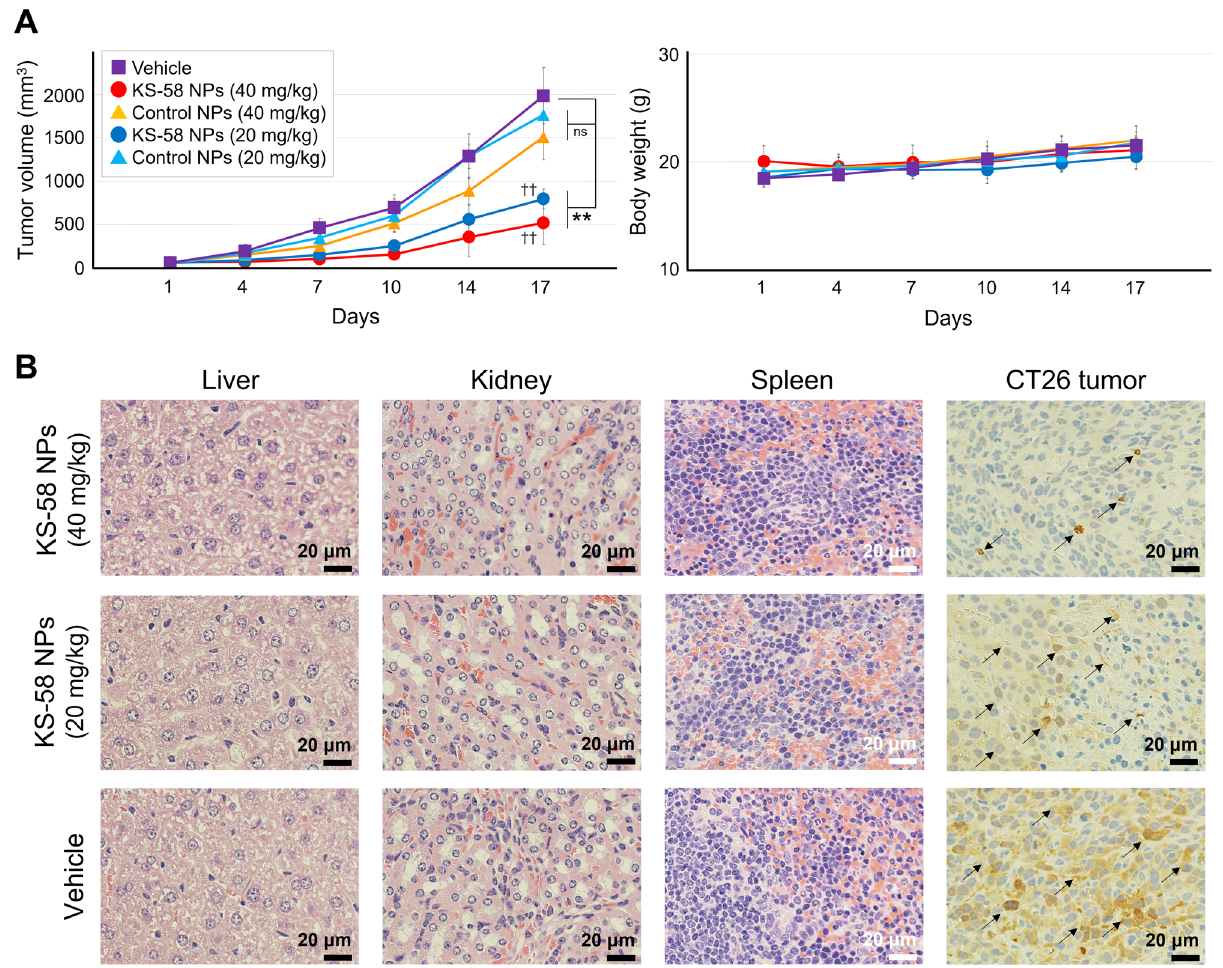
Figure 4. Antitumor efficacy of KS-58 NPs in mice bearing CT26 subcutaneous allografts. ( A ) Changes in tumor volume and body weight (n = 4 mice per group, expressed as mean ± SD, ** p < 0.001 vs. Vehicle control by Dunnett’s test, †† p < 0.001 vs. Control NPs by a Student’s t-test). ( B ) Immunohistochemical (IHC) staining of tissue sections. Liver, kidney, spleen, and CT26 tumors were collected from the mice were fixed in 10% neutral-buffered formalin, embedded in paraffin, and sectioned. Livers, kidneys, and spleens were stained with hematoxylin and eosin. CT26 tumors were stained with an anti-pERK antibody. Black arrows represent color development regarding to the pEPK